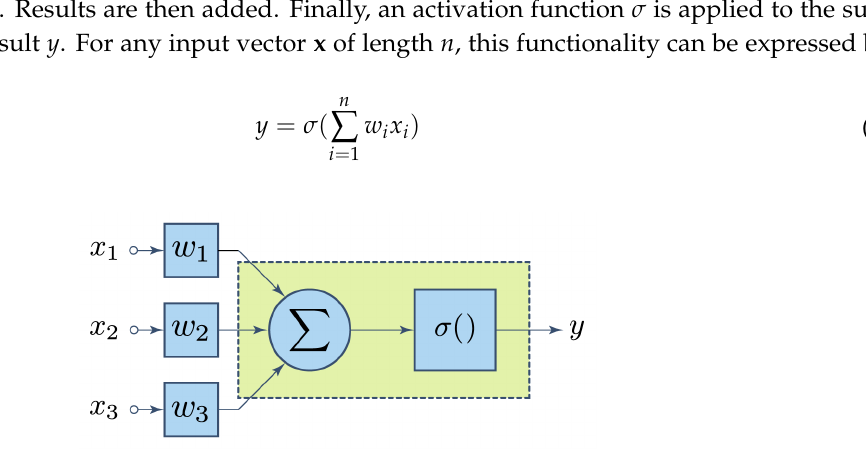
Figure 5. Schematic representation of a three-input perceptron.